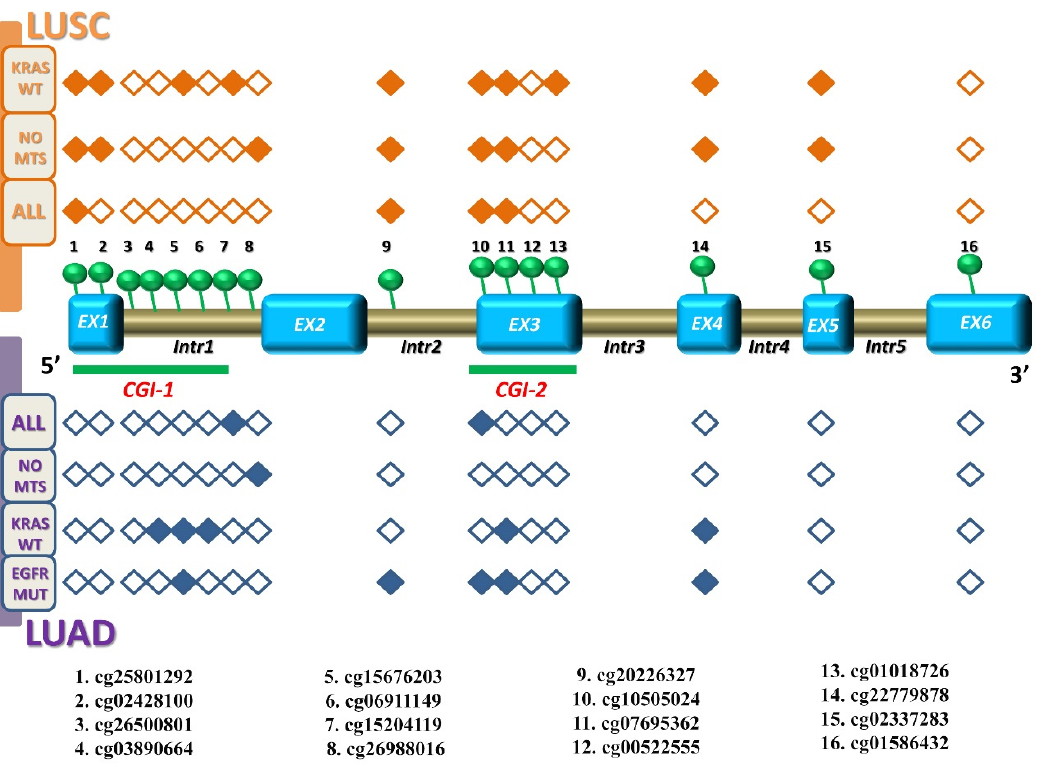
Figure 7. Correlation between KEAP1 CpGs methylation and KEAP1 transcript levels in LUSC and LUAD cohorts. The KEAP1 gene structure is shown in the middle, including exons (sky blue boxes) and introns (brown boxes), as well as its two CpG islands: CGI-1 and CGI-2 (both underlined with green bars). A total of 16 CpG sites, marked with green circles, are indicated from 5 ′ to 3 ′ genomic localization (listed below). A filled rhombus, corresponding to a KEAP1 CpG site, depicts a significant inverse correlation ( R ≤ − 0.1; p < 0.05) between methylation and transcription levels in LUSC (on the top, orange both for all, non-metastatic stages, and KRAS wild-type) and particularly in LUAD (on the bottom, blue both for all, non-metastatic stages, KRAS wild-type, and EGFR mutated), in contrast to an empty rhombus indicating no significant correlation. Abbreviations: EX, exon; Intr, intron; CGI-1, CpG Island 1; CGI-2, CpG Island 2; LUSC, lung squamous cell carcinoma; LUAD, lung adenocarcinoma; No-mts, non-metastatic disease stages.